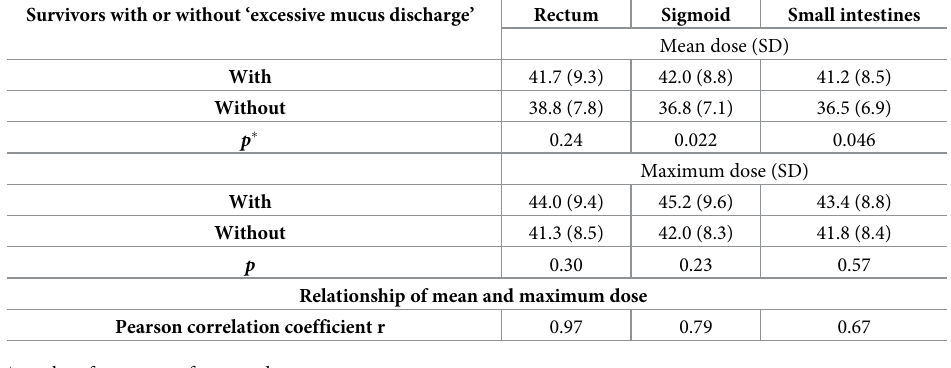
Table 2. Mean and maximum doses in the three OARs, for patients with and without ‘excessive mucus discharge’ and correlation coefficients between mean and maximum absorbed doses. Survivors with or without ‘excessive mucus